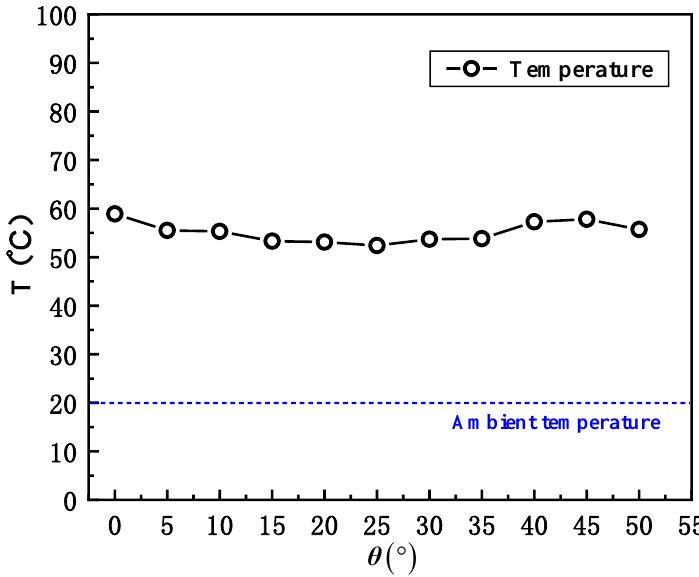
Figure 6. Temperature at H = 18 m above the fire source (200 – 400 s).